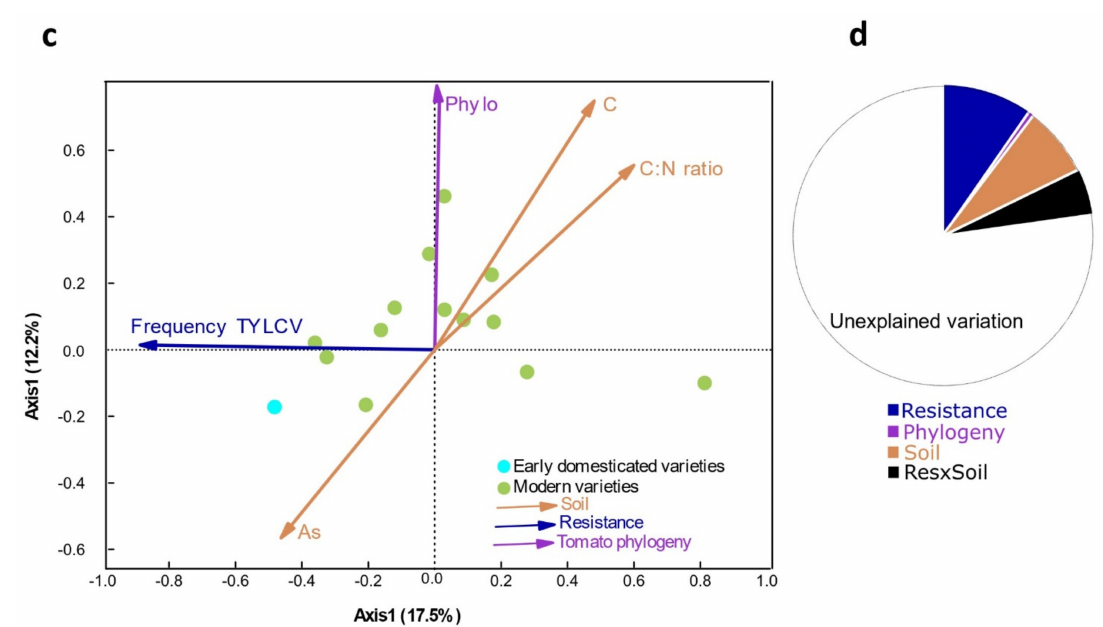
Figure 2. Redundancy analysis of bacterial OTU composition of tomato driven by plant (resistance and fruit morphology), soil (nutrients) and tomato phylogeny: ( a ) redundancy analysis; ( b ) varpart, including all three groups of tomato varieties; ( c ) redundancy analysis; ( d ) varpart, excluding wild